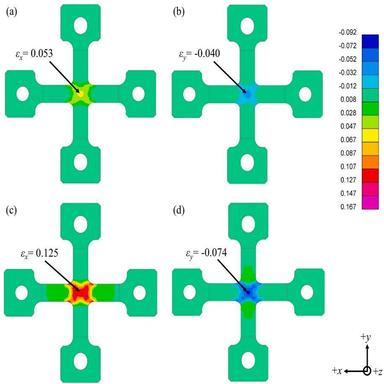
Predicted macro-strain in DP600 specimen during continuous strain path change: (a) εx and (b) εy strain distribution along uniaxial strain path before the strain path transition and (c) εx and (d) εy strain distribution after the strain path transition to biaxial strain path.